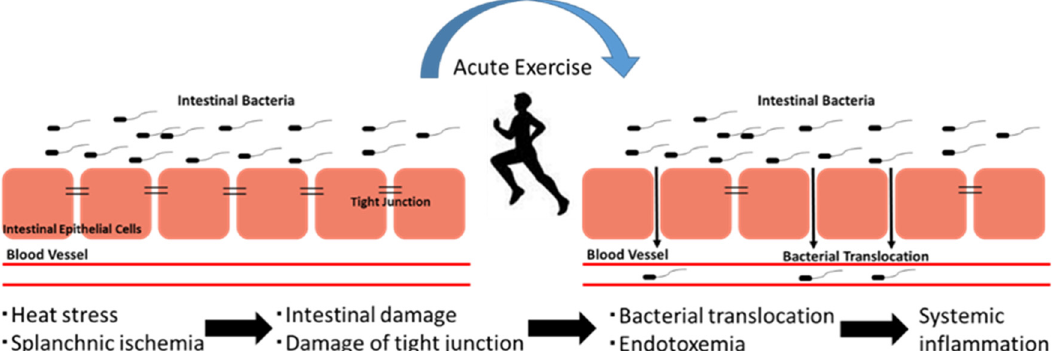
Figure 2. The concept of exercise-induced endotoxemia and systemic inflammation. Exercise induces intestinal barrier dysfunction and hyperpermeability. Subsequently, gut-derived bacteria translocate to the circulation and induce systemic inflammation.